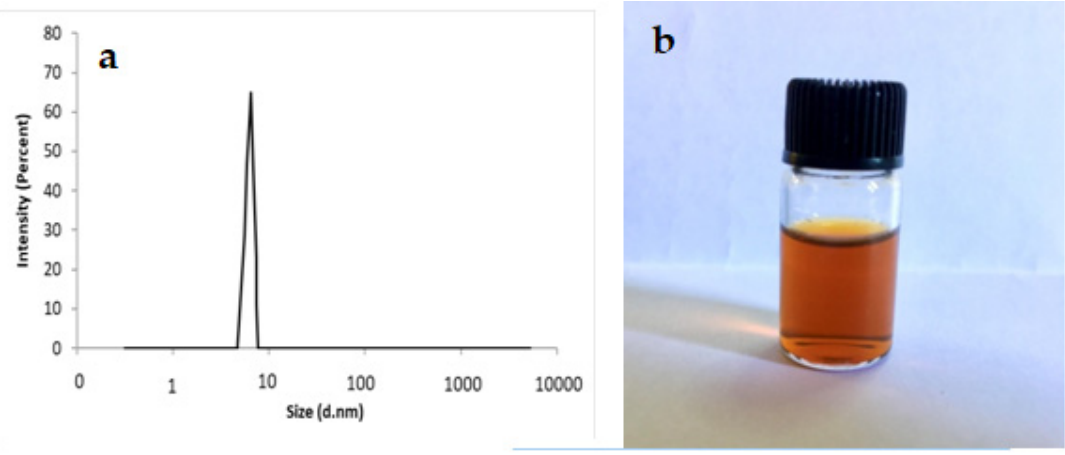
Figure 1. DLS results: ( a ) size distribution; ( b ) visual stability of microemulsion after six months.